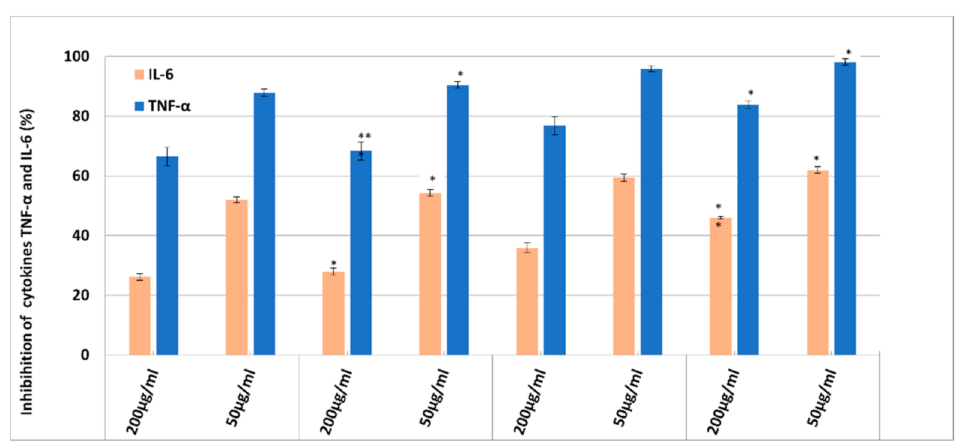
Figure 10. Inhibition action NLC-DSG- Yam on the release of TNF- α and IL-6 pro-inflammatory cytokines. * p < 0.05; ** p < 0.005; NS p > 0.05. Data are expressed as mean ± SD, n = 3 NLC-1/2 vs. other